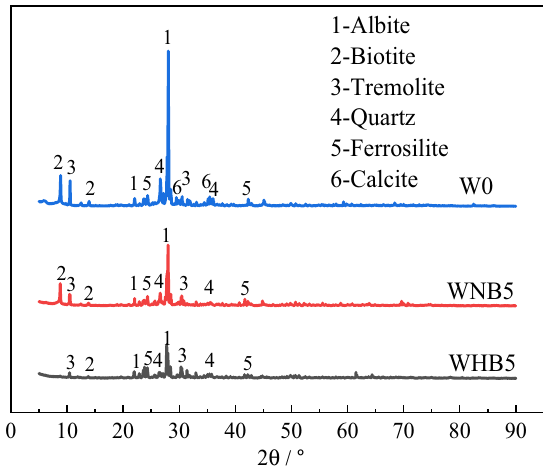
Fig. 13 XRD pattern of the unactivated and activated tailings powder